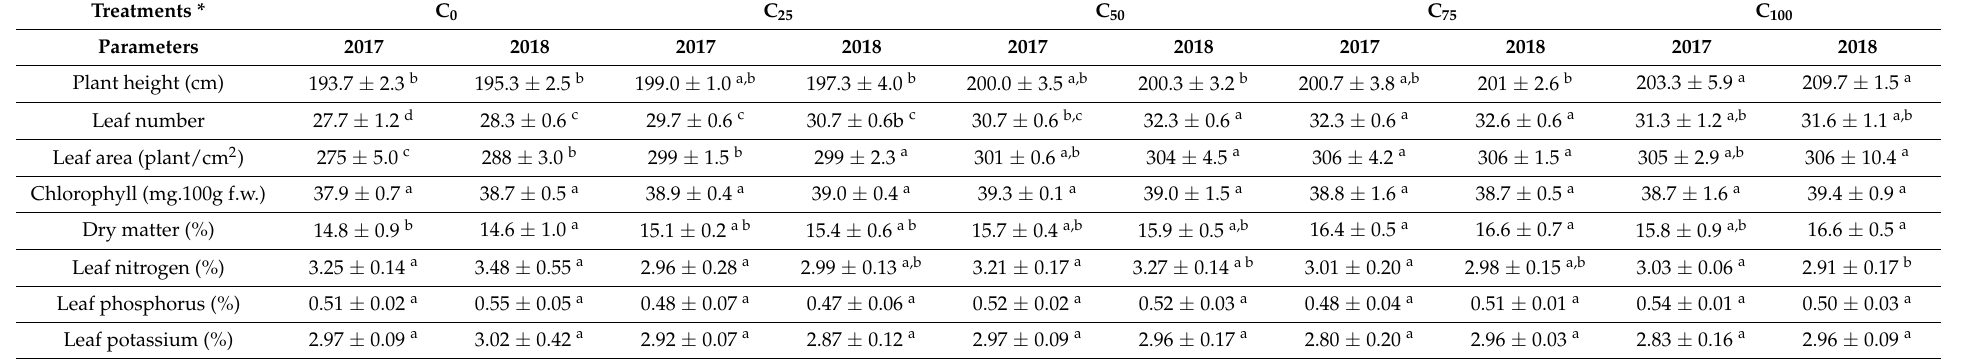
* Represented data are mean ± SD ( n = 3). Different superscript letters in each row indicate significant differences ( p < 0.05). TAM: seaweed liquid extract; C 0 : 100% NPK mineral fertilizer as control; C 25 : 25% TAM (1.25 cm of crude extract/liter) + 75% NPK mineral fertilizer; C 50 : 50% TAM (2.5 cm of crude extract/liter) + 50% NPK mineral fertilizer; C 75 : 75% TAM (3.75 cm of crude extract/liter) + 25% NPK mineral fertilizer; and C 100 : 100% TAM (5 cm of crude extract/liter). Table 6. The influence of different TAM doses on the fruit characteristics of cucumber C. sativus and N, P, K content cultured under a greenhouse during the 2017/2018 growing seasons. Treatments * Parameters